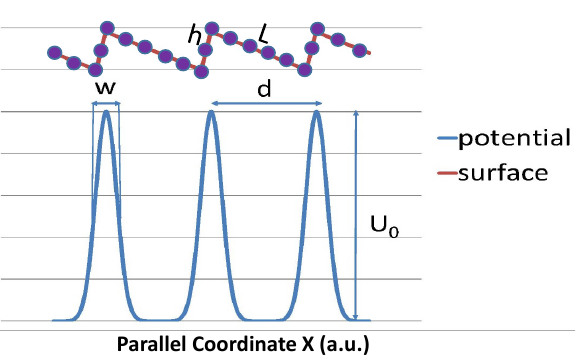
Figure 1. The one-dimensional Kronig-Penney potential [7] and the vicinal surface it models with terrace width ( L ) and step height ( h